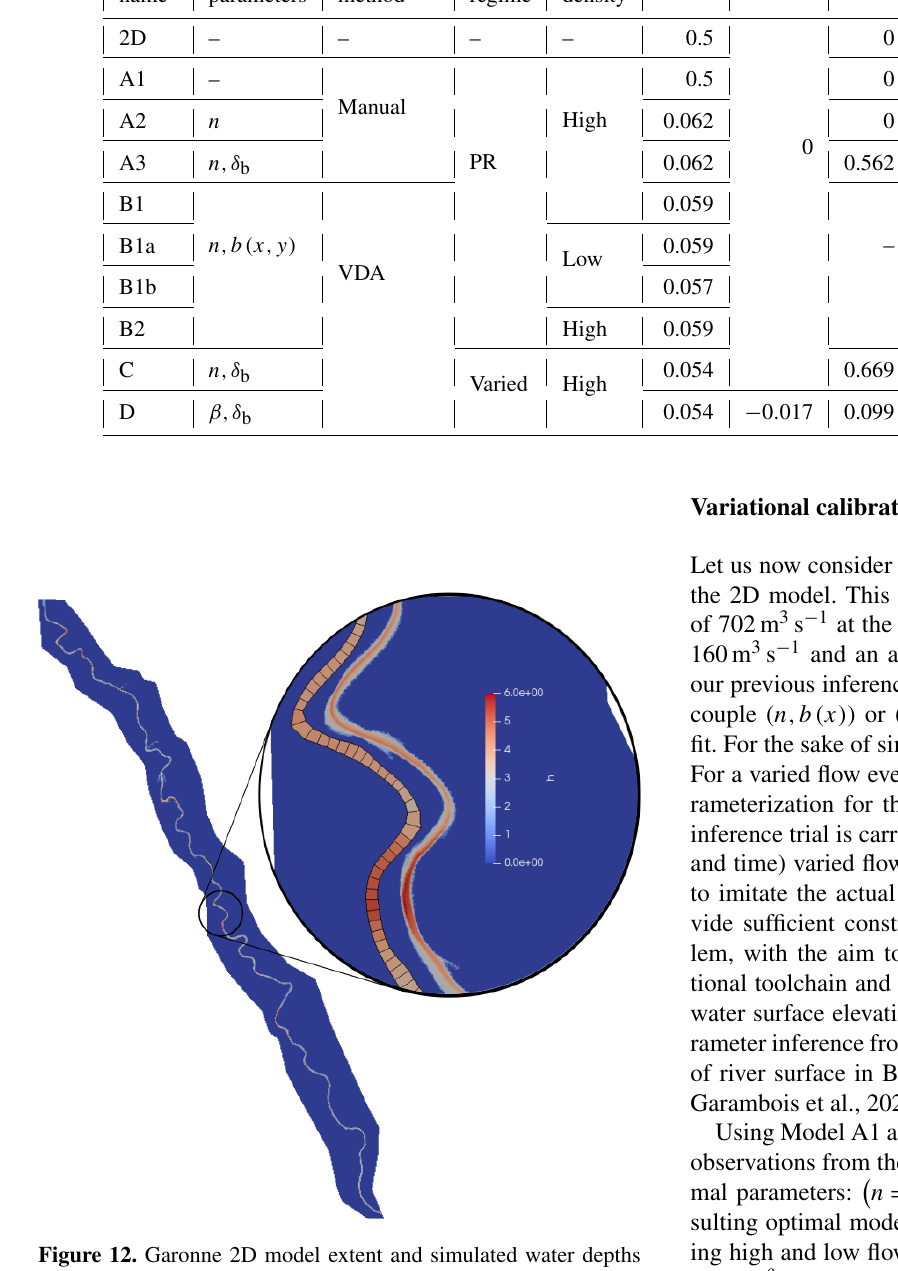
Figure 12. Garonne 2D model extent and simulated water depths using the 2D model and the 1D-like model for a non-flooding event. In the zoom, both models are represented, with a slight longitudinal shift for the 1D-like model, to allow qualitative comparison of both simulated water depth and water surface